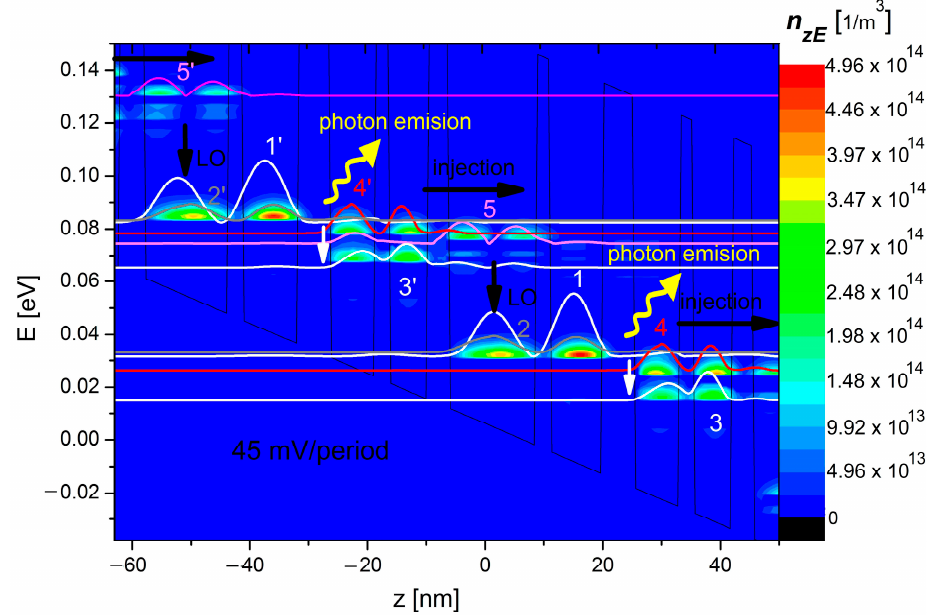
Figure 10. The spatially and energetically resolved electrons density n (z, E ) with the five lowest WSS states. The simulation was performed with Born’s approximation procedure (BAP) for the structure no. 2, described in [24] at the assumed temperature T = 25 K and with the bias voltage equal 45 mV per period.